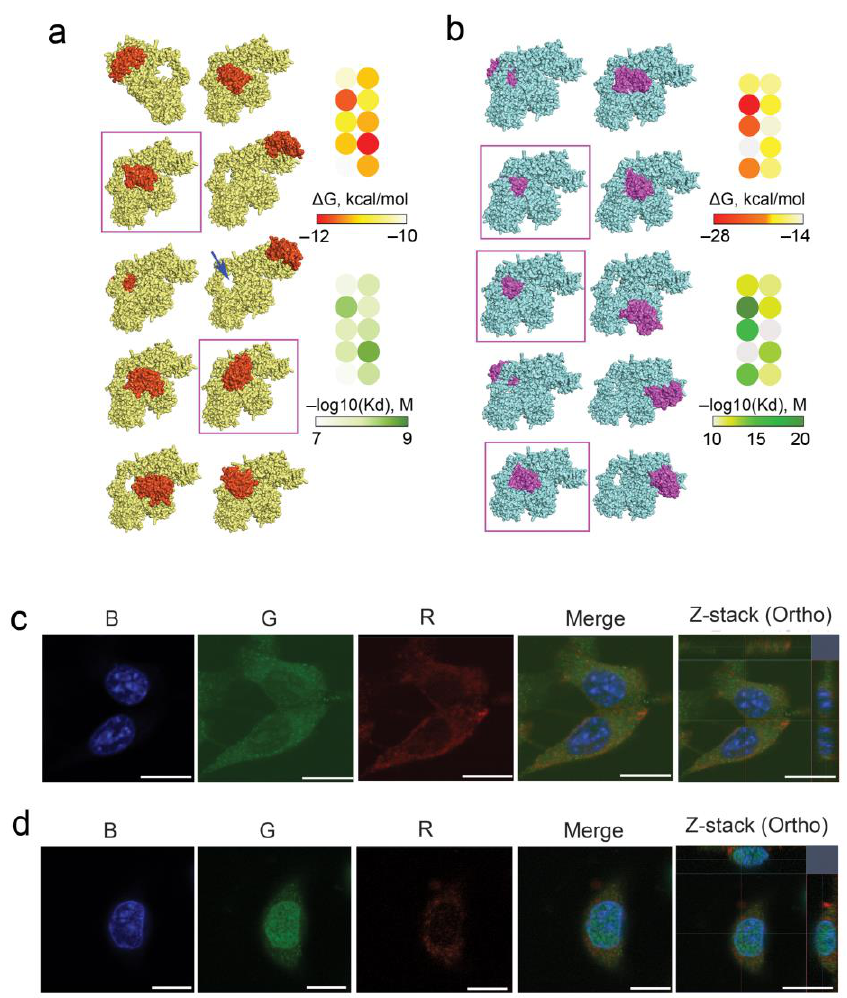
Figure 2. Interaction of RNase A with Ku70/Ku80 heterodimer. ( a , b ) Structures of the complex between RNase A and Ku70/Ku80 obtained by molecular modeling using bioinformatics platforms HDOCK server and PatchDock, respectively. The ∆ G values of RNase A binding to Ku70/Ku80 heterodimer and corresponding dissociation constants (Kd) were calculated for each obtained struc- ture using the PRODIGY resource. Heterodimer Ku70/Ku80 is yellow ( a ) or blue ( b ), and RNase A is orange ( a ) or purple ( b ). The arrow ( a ) shows the DNA-binding loop formed by Ku70/Ku80 heterodimer. Docking complexes characterized by the smallest values of ∆ G and Kd are highlighted with purple frames. ( c , d ) Accumulation of RNase A in B16 and HeLa cells, respectively, and its co-localization with Ku70/Ku80 heterodimer. B16 and HeLa cells were incubated in the presence of RNase A–biotin conjugate (20 µ M) for 4 h followed by staining with streptavidin-APC, Ku70/Ku80 monoclonal antibody and secondary antibody with Alexa Fluor Plus 488 and analyzed by confocal fluorescence microscopy. Fluorescence in the blue channel (B panel) corresponds to DAPI (staining of nuclei), the green channel (G panel) corresponds to Ku70/Ku80 Alexa Fluor Plus 488 and the red channel (R panel) corresponds to RNase A–biotin conjugate stained with streptavidin-APC. Scale bars: 10 µ